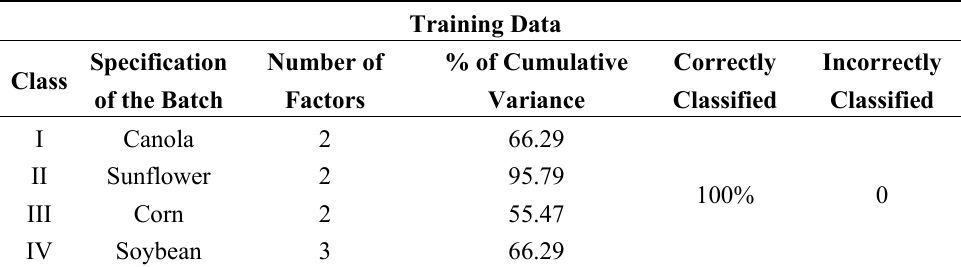
Table 3. Summary of the results for the SIMCA model.